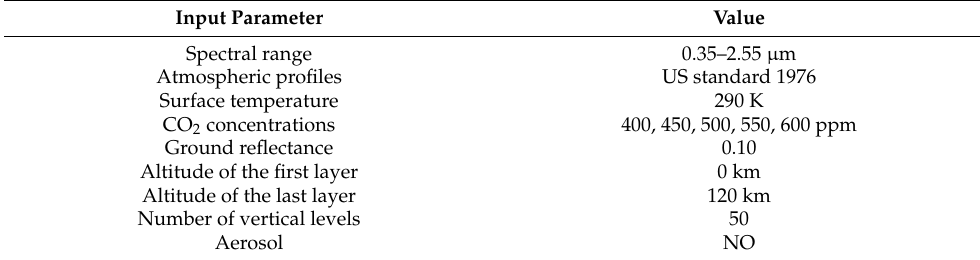
Table 1. Input parameters for a set of five MODTRAN runs.